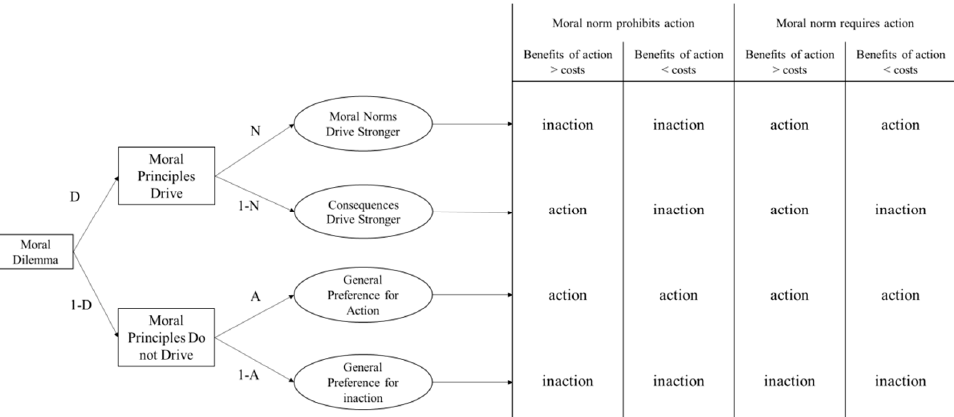
Figure 2. An alternative multinomial processing tree model constructed based on the corrective dual-process model of morality (the model can support the parallel processing logic and parameter calculation of the CAN algorithm). Note. D denotes that the agent’s choices are driven by moral principles (norms or consequences), and N denotes that the agent’s choices are driven more by norms. (1 − N ) denotes that the agent’s choices are driven more by consequences. A denotes that the agent’s choices are driven by a preference for action, while moral principles do not drive their responses. According to the mechanism of the multinomial processing tree model, four equations are obtained, p 1 = D × (1 − N) + (1 − D) × A; p 2 = (1 − D) × A; p 3 = D × N + D × (1 − N)